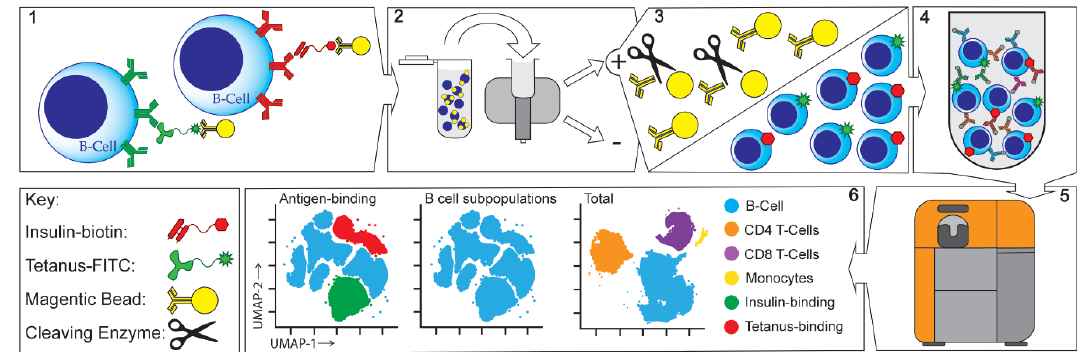
Figure 1. Schematic for magnetic enrichment of antigen-reactive B cells. 1. Human PBMCs are incubated with properly titrated amounts of biotin and FITC-labeled antigens. Cells are then incubated with a combination of cleavable anti-biotin and anti-FITC magnetic beads. 2. Washed cells are then added to a magnetic column and separated into depleted and enriched fractions. 3. Magnetic microbeads are cleaved off and washed away. 4. Cells are then incubated with an antibody cocktail containing various metal labeled antibodies. 5. Cells are analyzed on a mass cytometer. 6. Data analysis is performed using a combination of manual gating and dimensionality reduction and clustering algorithms.